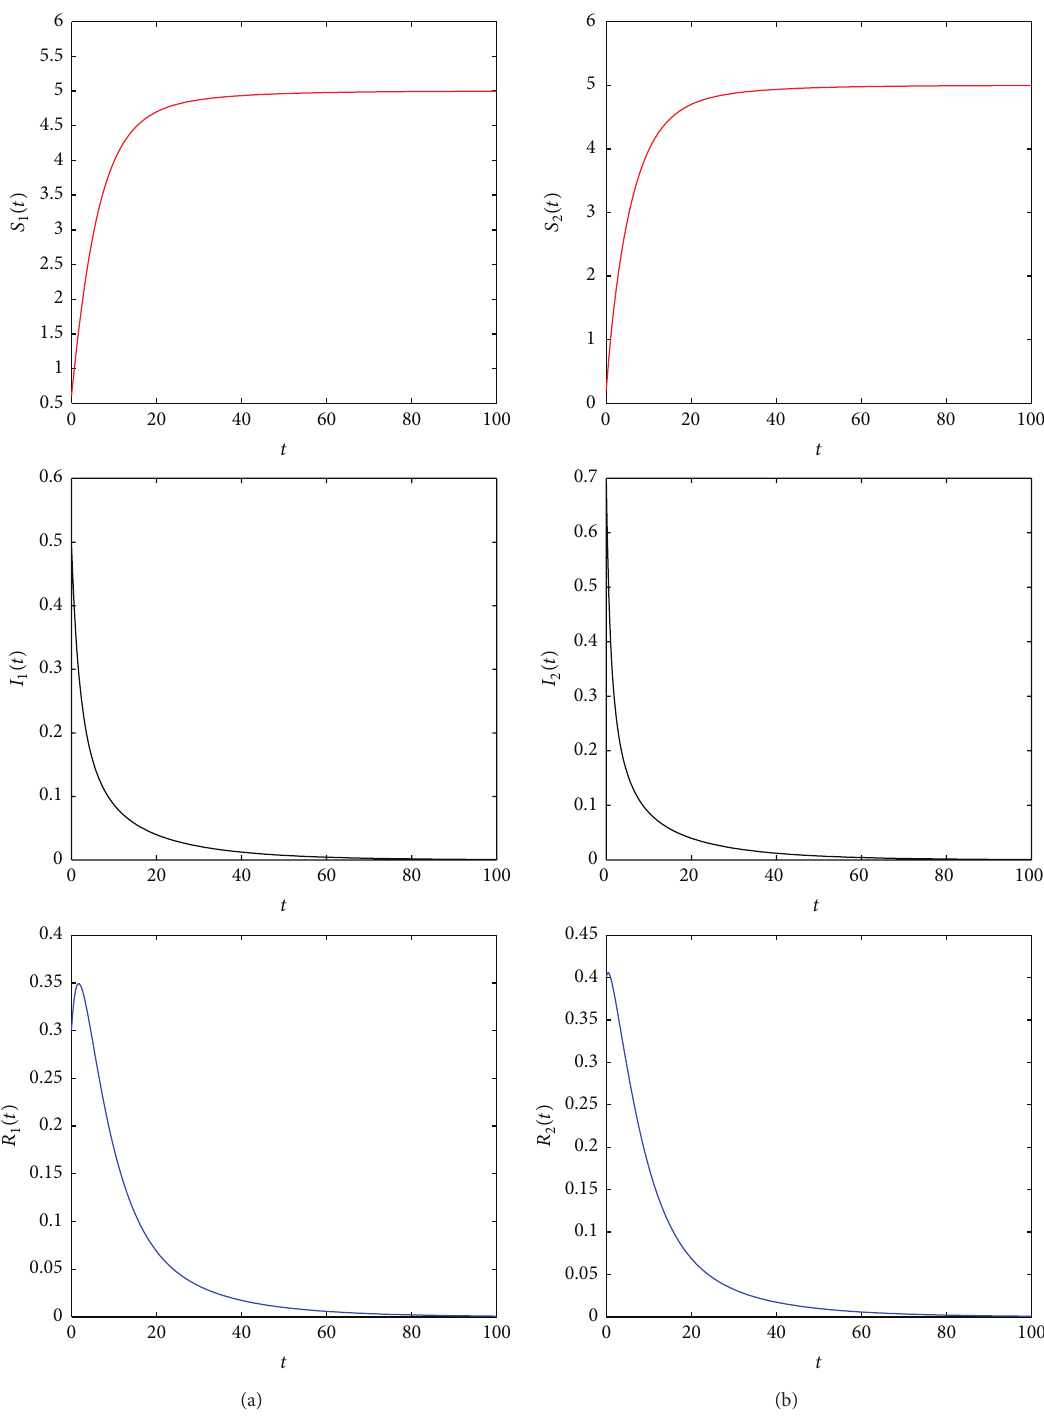
If we set 𝑎 = 1 , 𝑏 = 0.2 , 𝑐 = 0.4 , 𝑑 = 0.2 , 𝛼 = 0.3 , 𝛽 = 0.6